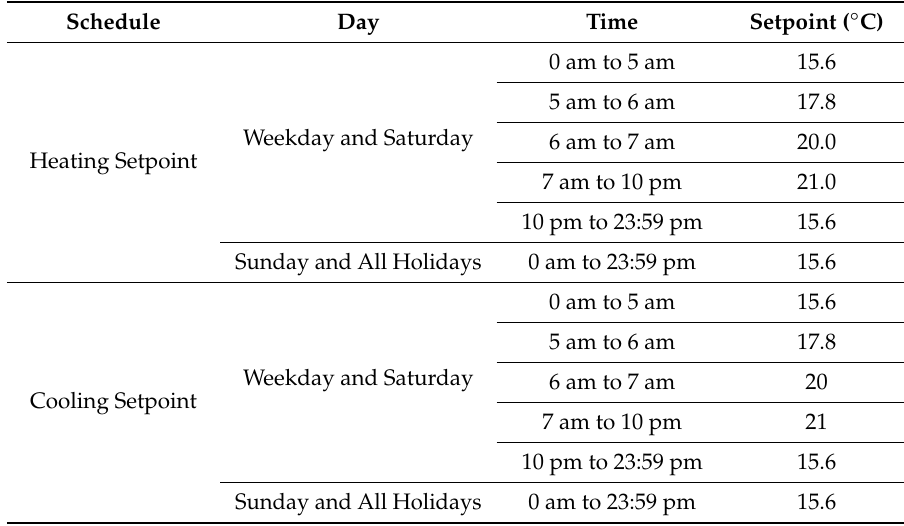
Table A4. Heating and cooling setpoint schedules for the